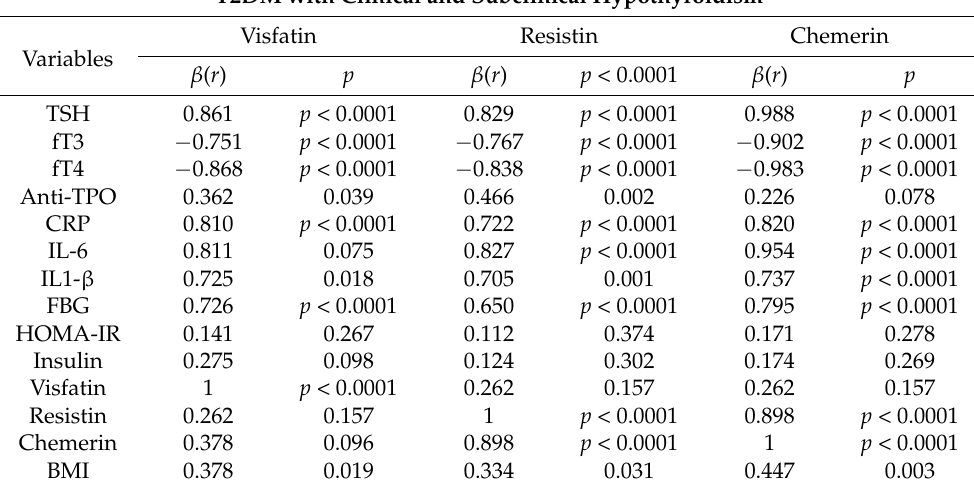
Chemerin 0.378 BMI 0.378